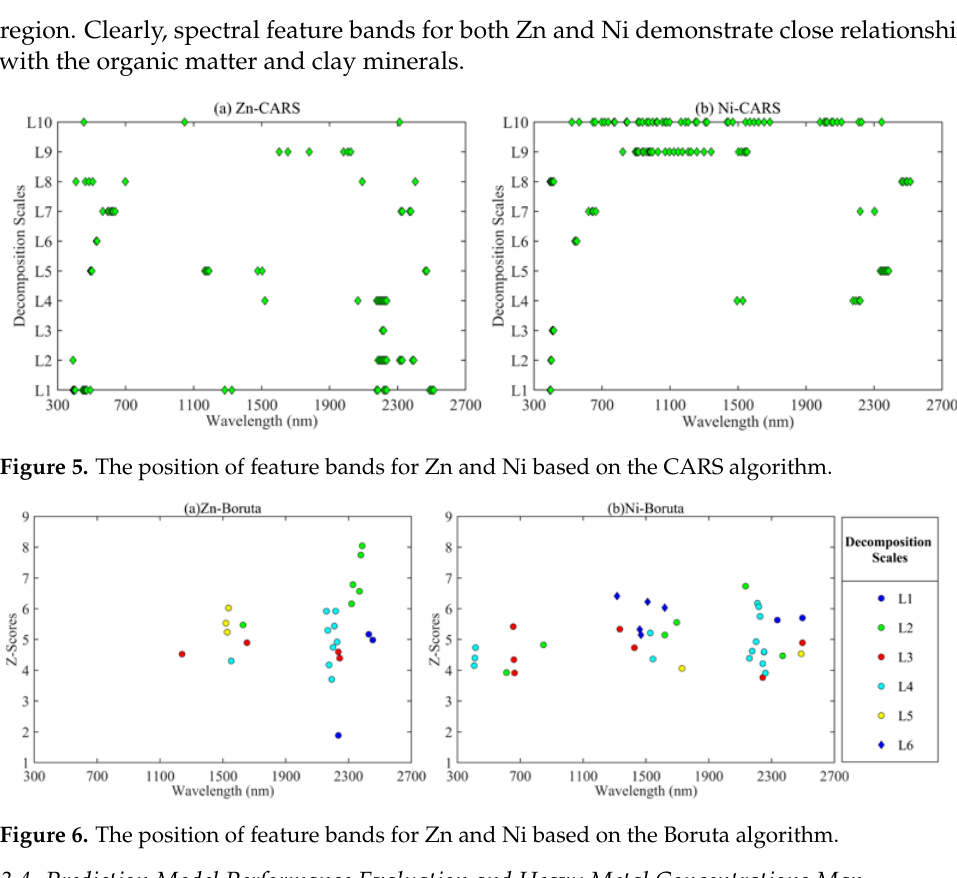
Figure 6. The position of feature bands for Zn and Ni based on the Boruta algorithm.